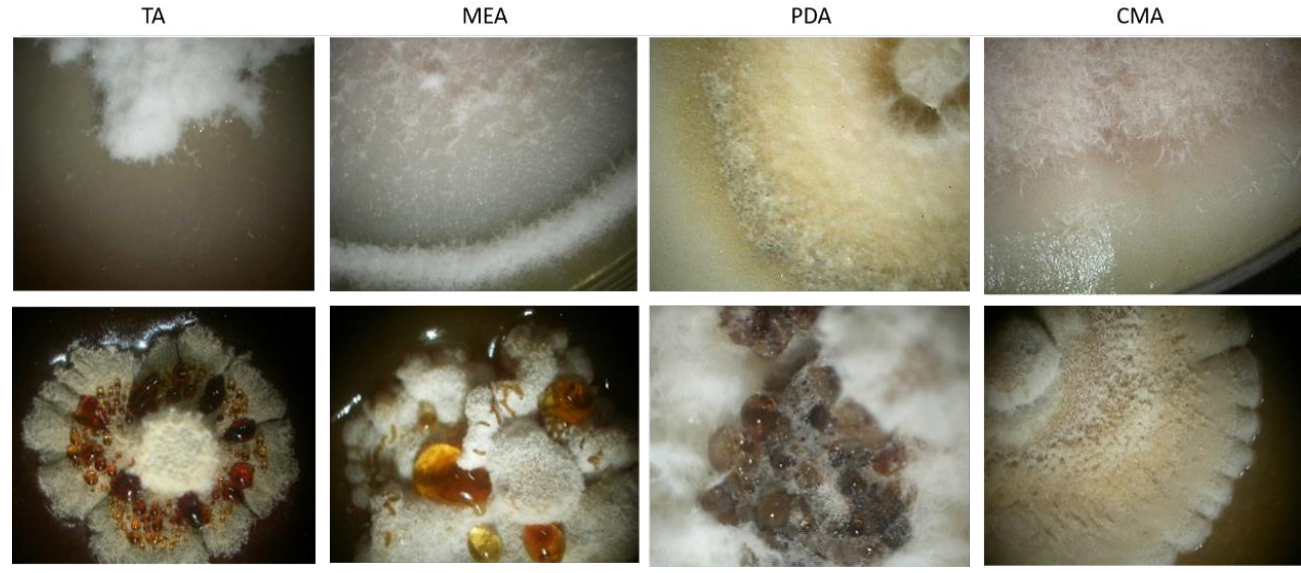
Figure 6. Colony and sporulation of two Neofabraea sp. isolates on different culture media after 2 months of incubation. The first row represents isolate J60 (morphotype I), while the second row represent isolate J117 (morphotype II).